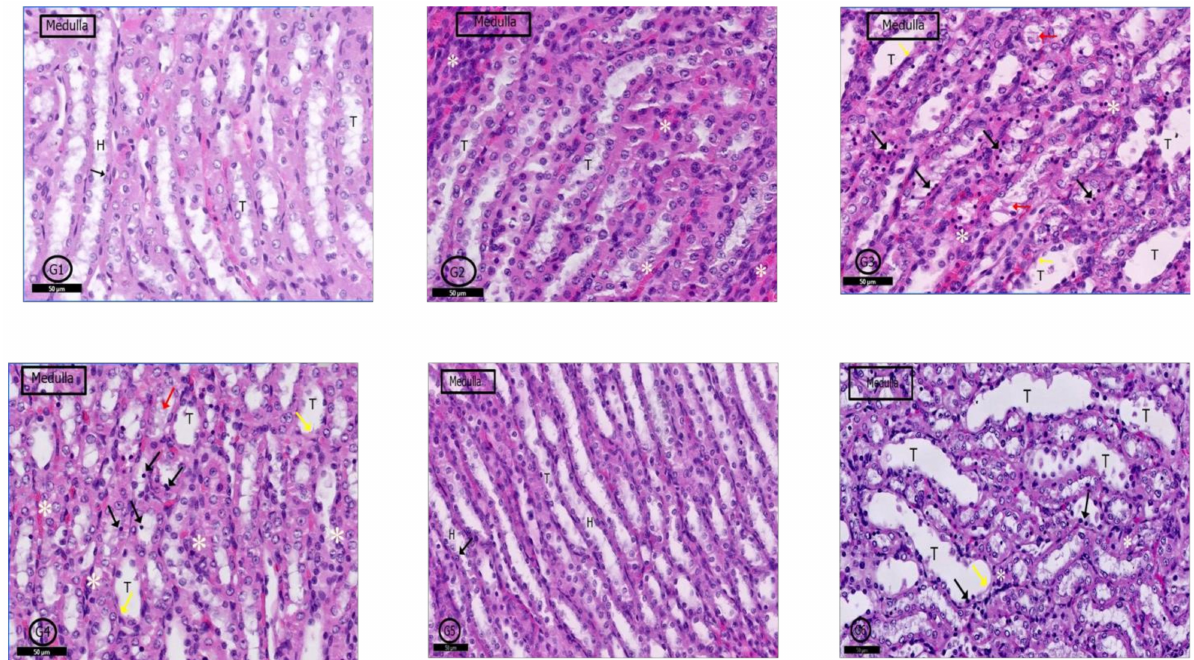
Figure 10. Photomicrographs of the rat renal medulla of different groups: In ( G1 ) (control rats), the renal medulla was filled with normal collecting renal tubules (T) and loops of Henle (H). Loop of Henle lined by flattened cells with rounded nuclei ( ↑ ). In ( G2 ) (PILO rats), renal medulla was normal but mild vascular congestion was observed (*). In ( G3 ) (PILO+LPS rats) and ( G4 ) (PILO+LPS+VPA rats) wide range of degenerated cells (black ↑ ), widen tubules (T) and congested blood vessels (*). Notice spread of the cellular casts (red ↑ ) and denuded lining (yellow ↑ ). ( G5 ) (PILO+LPS+Celecoxib rats) showed nearly normal histological profile of renal medulla; the renal tubules (T) and loops of Henle (H) and round nuclei of their flattened cells ( ↑ ). ( G6 ) (PILO+LPS+VPA+Celecoxib rats) showed degenerated cell lining (black ↑ ) and widened tubules (T). Notice denuded lining (yellow ↑ ) of the tubules and mild interstitial cell infiltrations with inflammatory cells. Stain: H&E. Bars: 50 µ